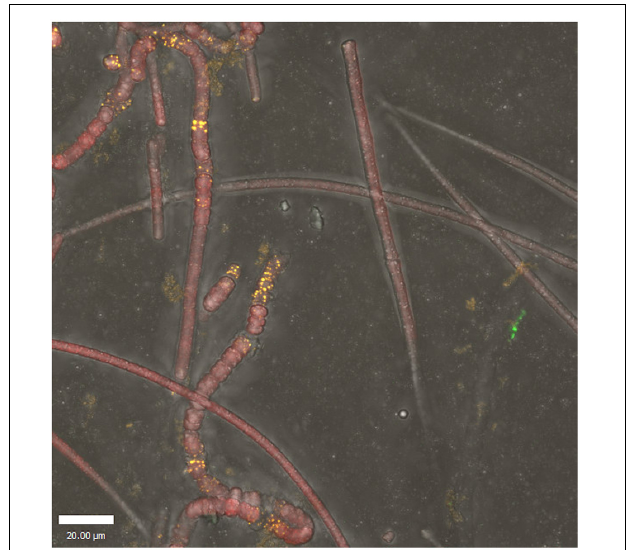
FIGURE 6 | Localization of A. marincola HL-49 within UCC-O biofilms via fluorescence in situ hybridization. Image represents a maximum-intensity Z-projection of a stack of confocal images, scale bar denotes 20 mm. Fluorescence intensity from FISH probes targeted against A. marincola HL-49 16S ribosomal RNA is depicted in yellow. Cyanobacterial chlorophyll a and phycocyanin auto-fluorescence intensity appear in red within filaments of Phormidium sp. OSCR. Fluorescence images are overlaid upon a differential interference contrast image of consortium biomass to display cell